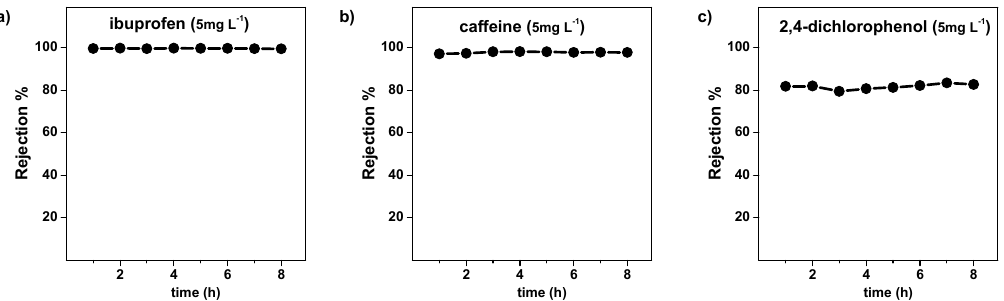
Figure 9. Rejection% of the SiC-fob membrane for model organic contaminants, namely ( a ) ibuprofen, ( b ) caffeine, and ( c ) 2,4-dichlorophenol. The starting concentration on the feed tank was 5 mg L − 1 for all the pollutants, rejection was calculated by Equation (1) (feed inlet = 73 °C, feed outlet = 59 °C, permeate inlet = 11 °C, permeate outlet = 31 °C).